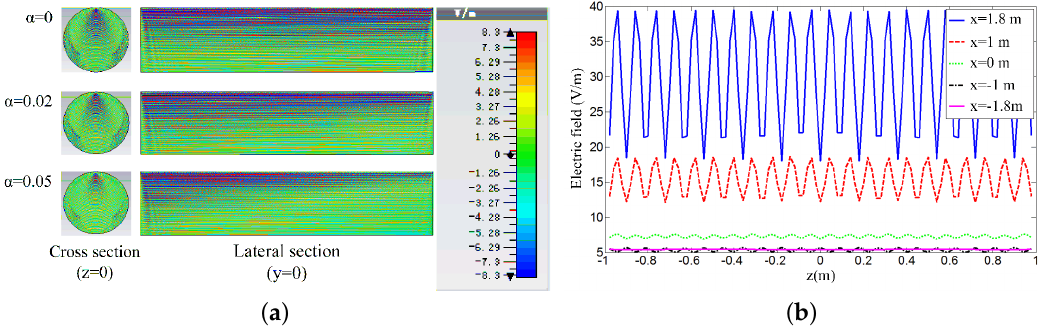
Figure 3. Field distribution of the leaky waveguide method: ( a ) Field distribution ( E z ) with different α (Np/m). ( b ) The variations of field distribution ( E z component) with different heights x when α = 0